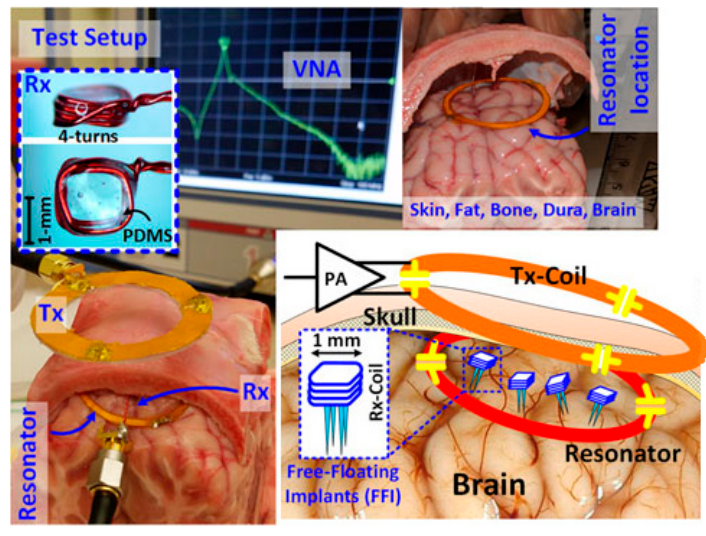
Figure 24. The three-coil link test setup, including a sheep brain and skull [145]. Copyright © 2017, IEEE.